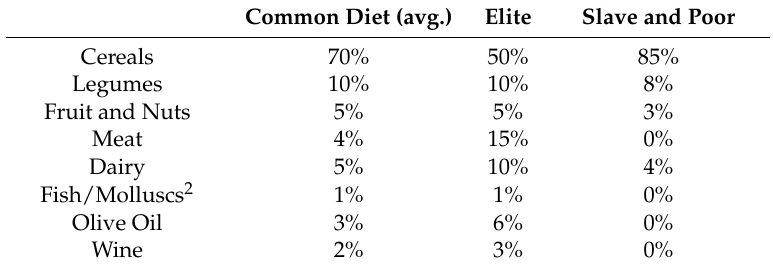
Table 1. Different hypothetical diet reconstructions depending on social status for the ancient Peloponnese. Common Diet